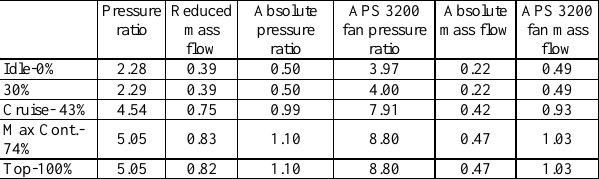
Table 13. Parameter of APS 3200 V = 0 Ma, H = 0 m Pressure ratio